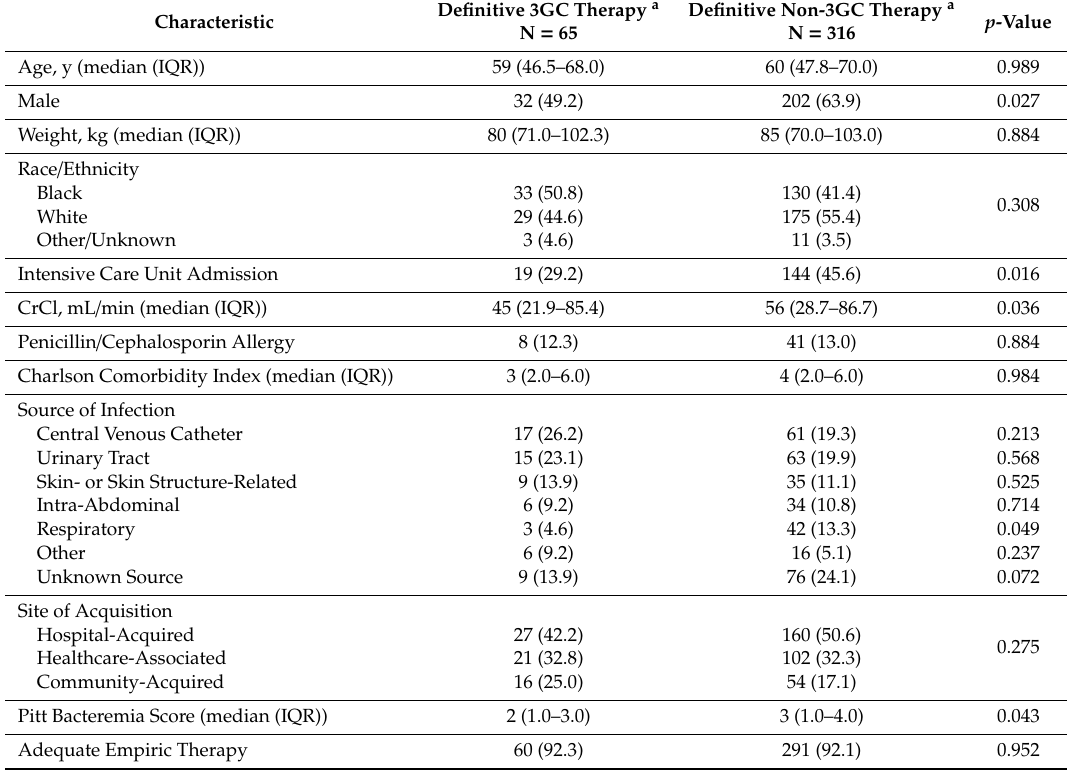
Table 1. Baseline characteristics of patients on definitive therapy with third-generation cephalosporin (3GC) versus other antimicrobial agents.